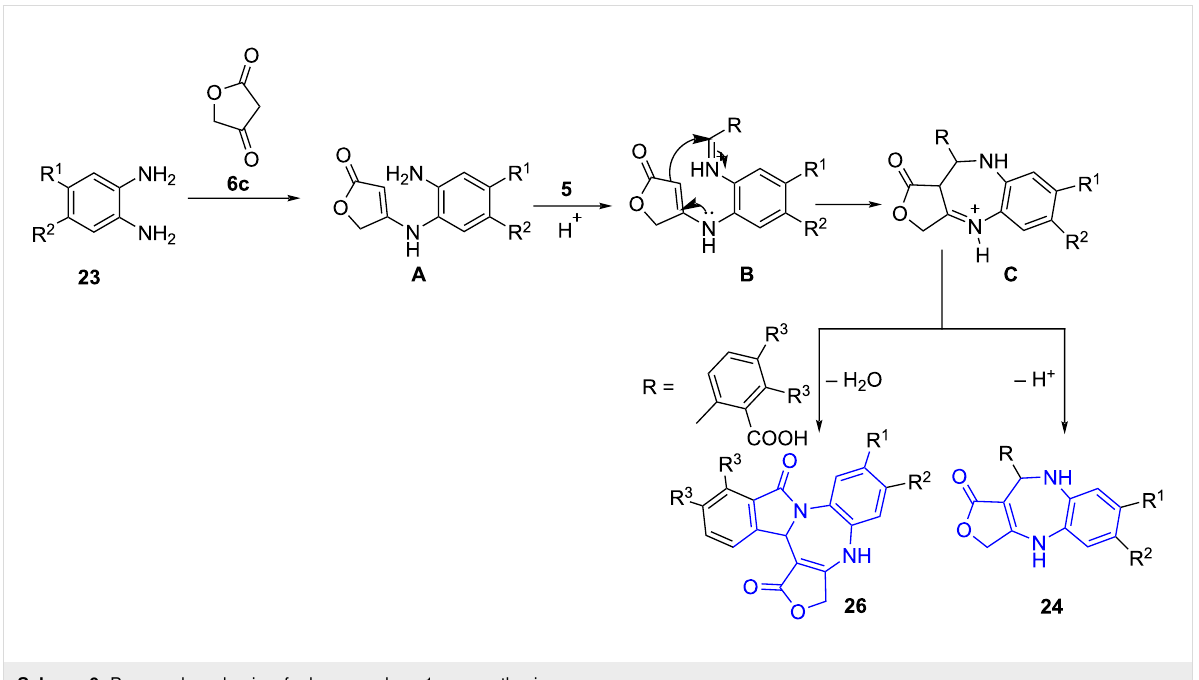
Scheme 9: Proposed mechanism for benzoazulene-1-one